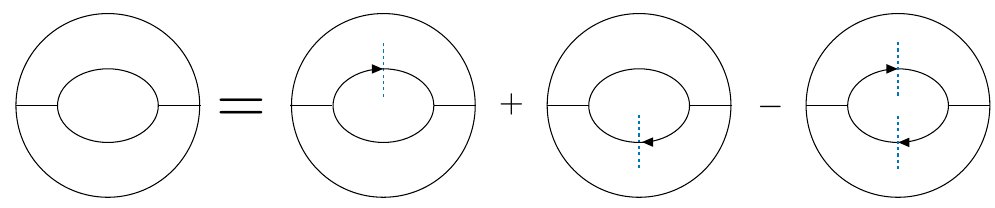
Figure 4 . Feynman tree theorem in AdS for a one-loop correction to the propagator in (cid:8) 3 theory. The arrow indicates the (cid:13)ow of positive energy across the